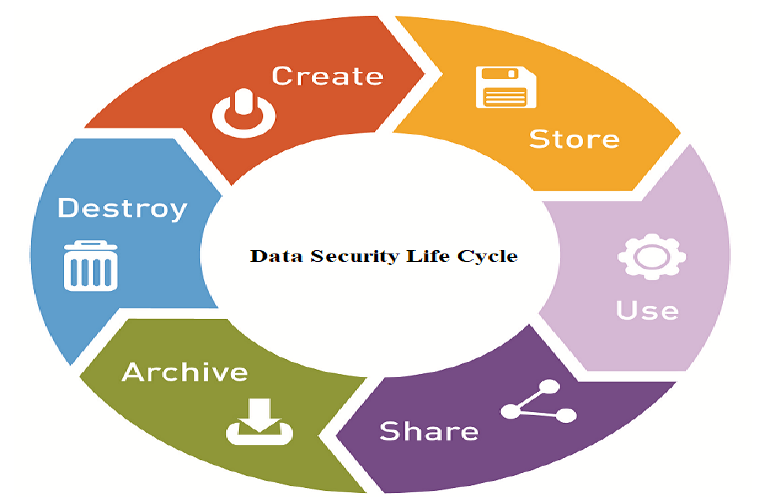
Figure 4 . Life Cycle of Data